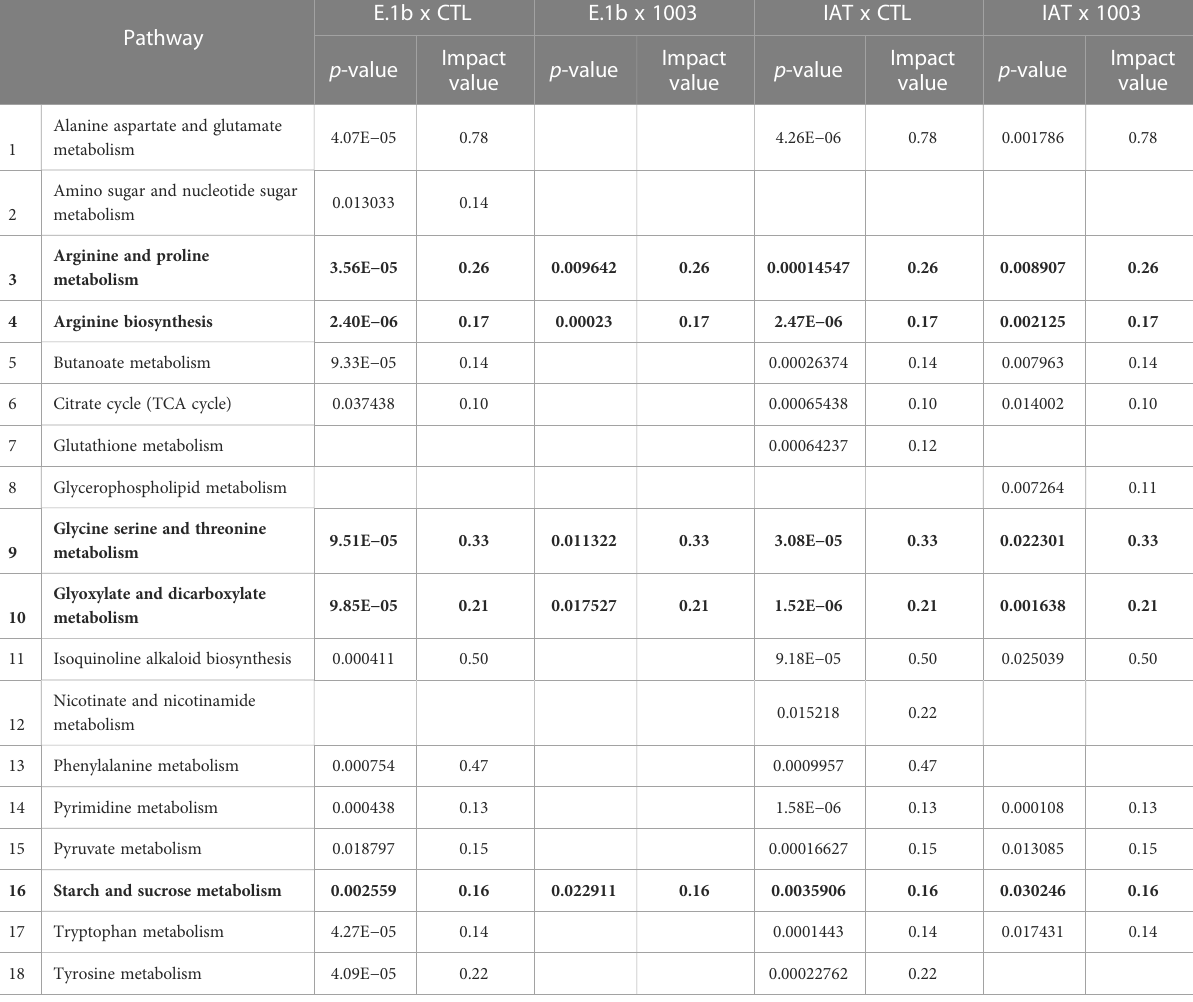
TABLE 1 Metabolic pathways affected in rice co-cultivated with IAT P4F9 and E.1b, compared to both controls.